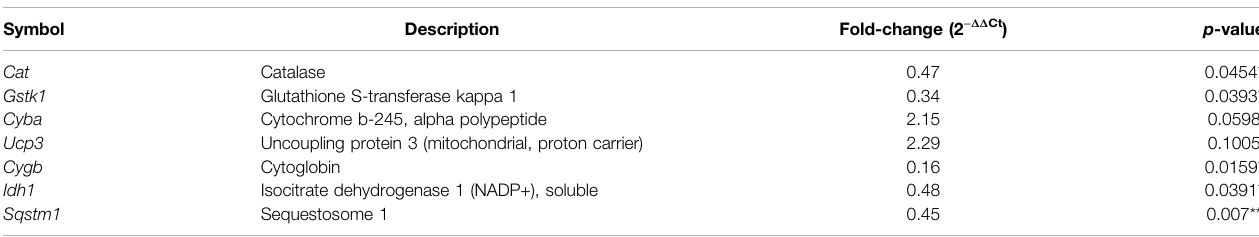
* and ** indicate signi fi cant differences from the sham group at p < 0.05 and p < 0.01, respectively. UFPM, ultra fi ne particulate matter; MI, myocardial